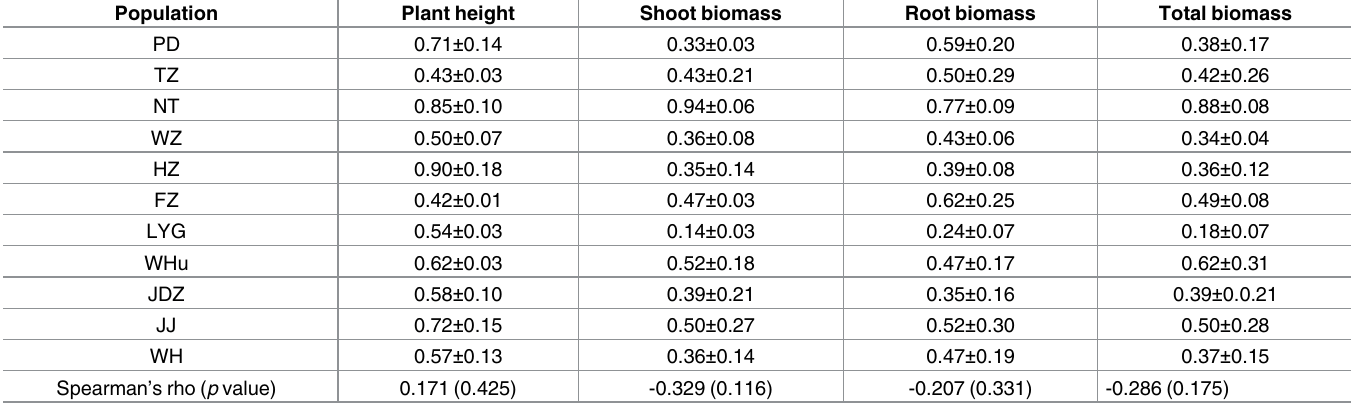
Table 2. Mean ± standard error (SE) of the salt tolerance for each trait of Solidago canadensis and nonparametric correlations with soil salinity levels.